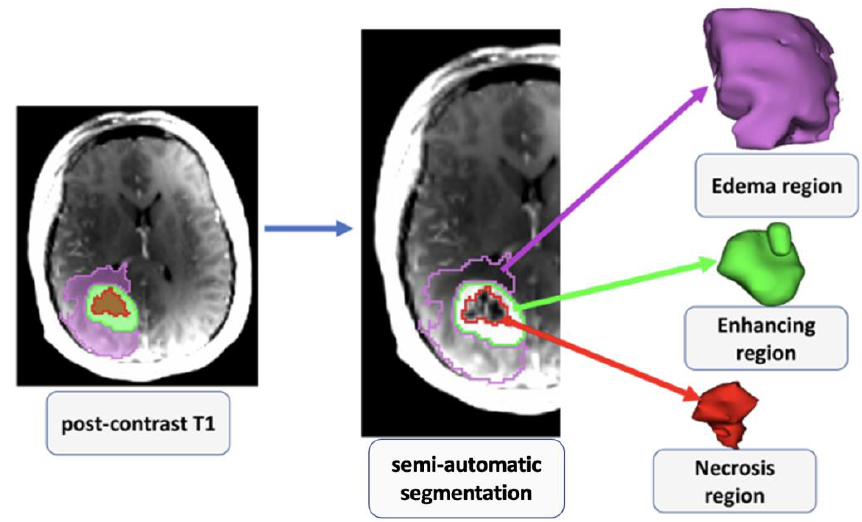
Figure 2. 2D and 3D visualization of various subregions of a grade 4 astrocytoma as visible on post-contrast T1-weighted image.